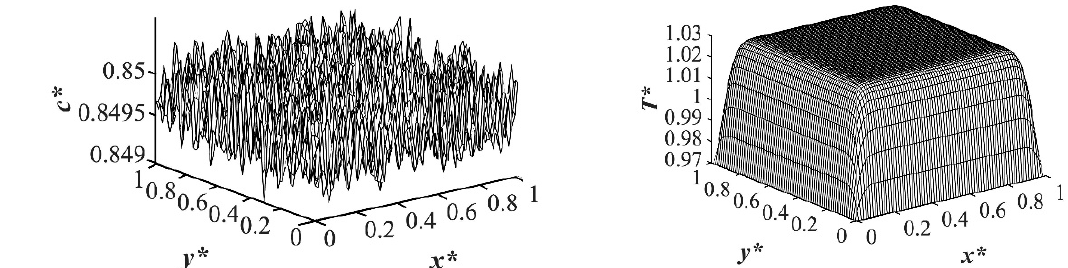
Figure 2. Spatial concentration ( left column) and temperature ( right column) profiles for the off- critical quench to c * = 0.85 at t * = 1.03 × 10 − 6 for three different quench depths of ( a ) T * q1 = 1.0, ( b ) T * q2 = 0.99 ( c ) T * q3 = 0.97.